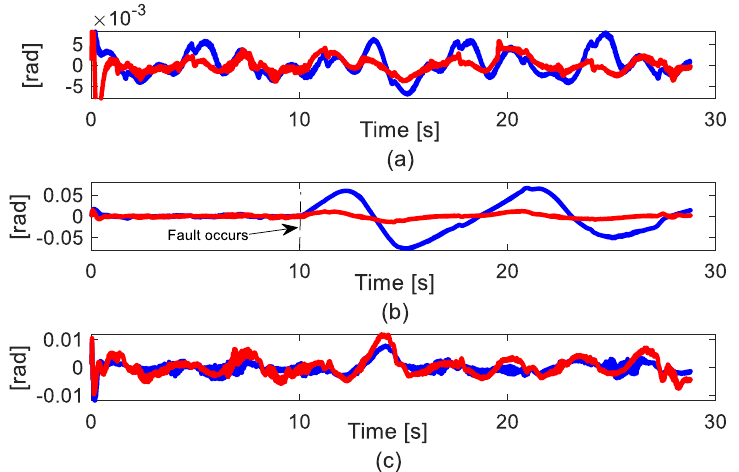
Figure 8. Tracking error results. Blue line is [30]+ESO controller. Red line is the proposed controller. ( a ) Joint 1; ( b ) Joint 2; ( c ) Joint (3).